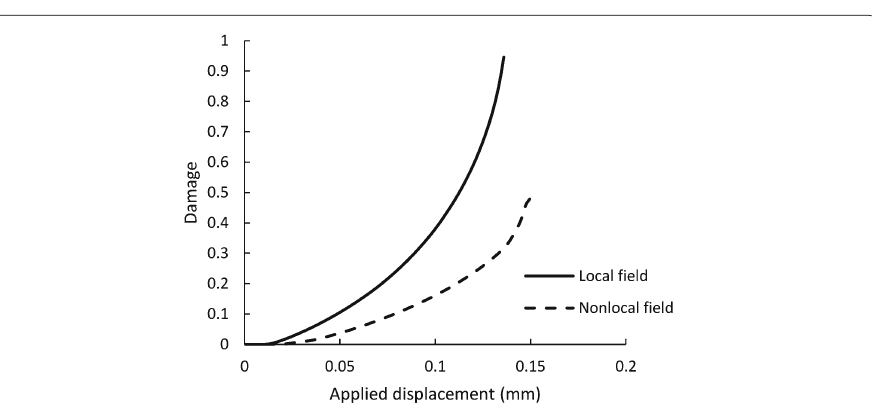
Fig. 8 Evolution of damage fields at the central node obtained from the refined